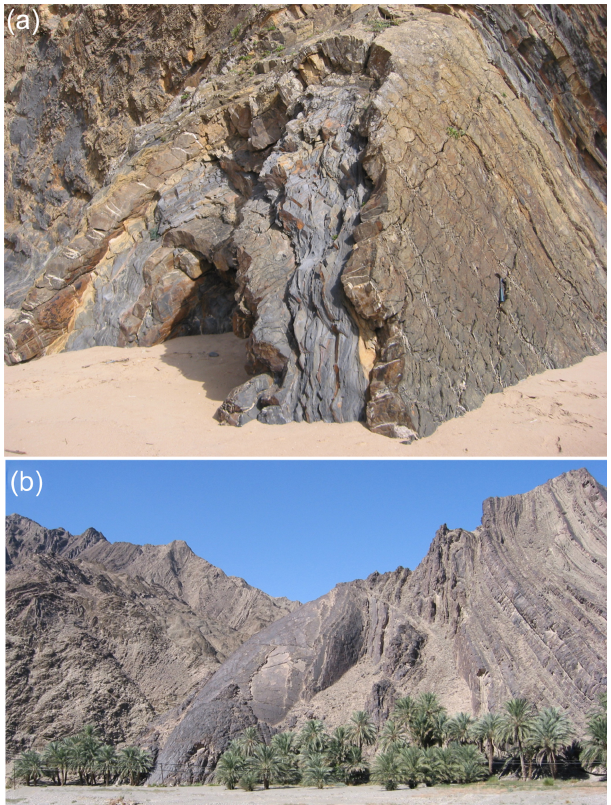
Figure 6. Outcrops showing the three-dimensional (3-D) geome- try of folds. (a) Folded turbiditic sequence from Almograve, Portu- gal. (b) Folded turbiditic sequences with a large fold hinge plung- ing towards the viewer from Makran region, Iran. Photographs by S.